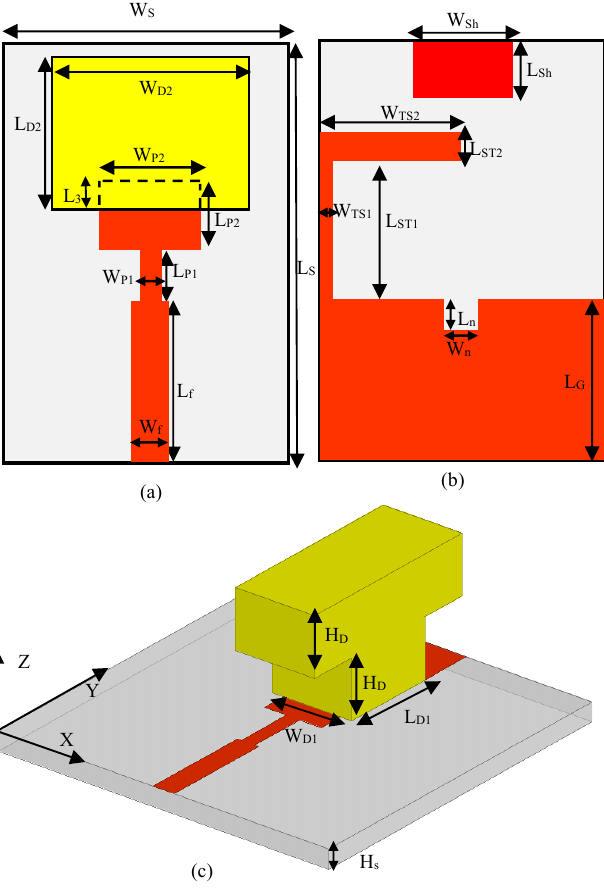
Figure 1: Geometry of the proposed UWB DRA (a) top view, (b) bottom view, and (c) 3-D view.